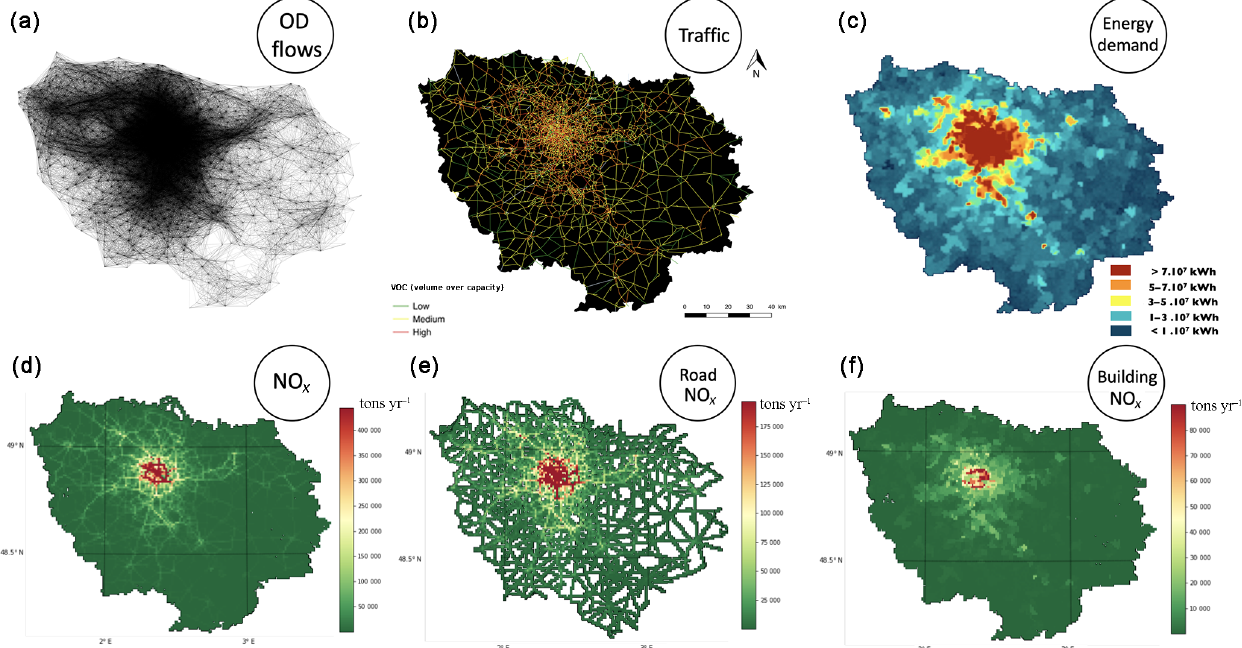
Figure 12. (a) Representation of all origin–destination flows generated by MOIRAI motion request module. (b) Representation of daily road traffic in greater Paris in terms of volume over capacity (VOC), (d) nitrogen oxide emissions in Île-de-France from road transport and residential–commercial–institutional sector (OLYMPUS), (e) focus on emissions from road transport, (f) focus on emissions from the residential–commercial–institutional sector.